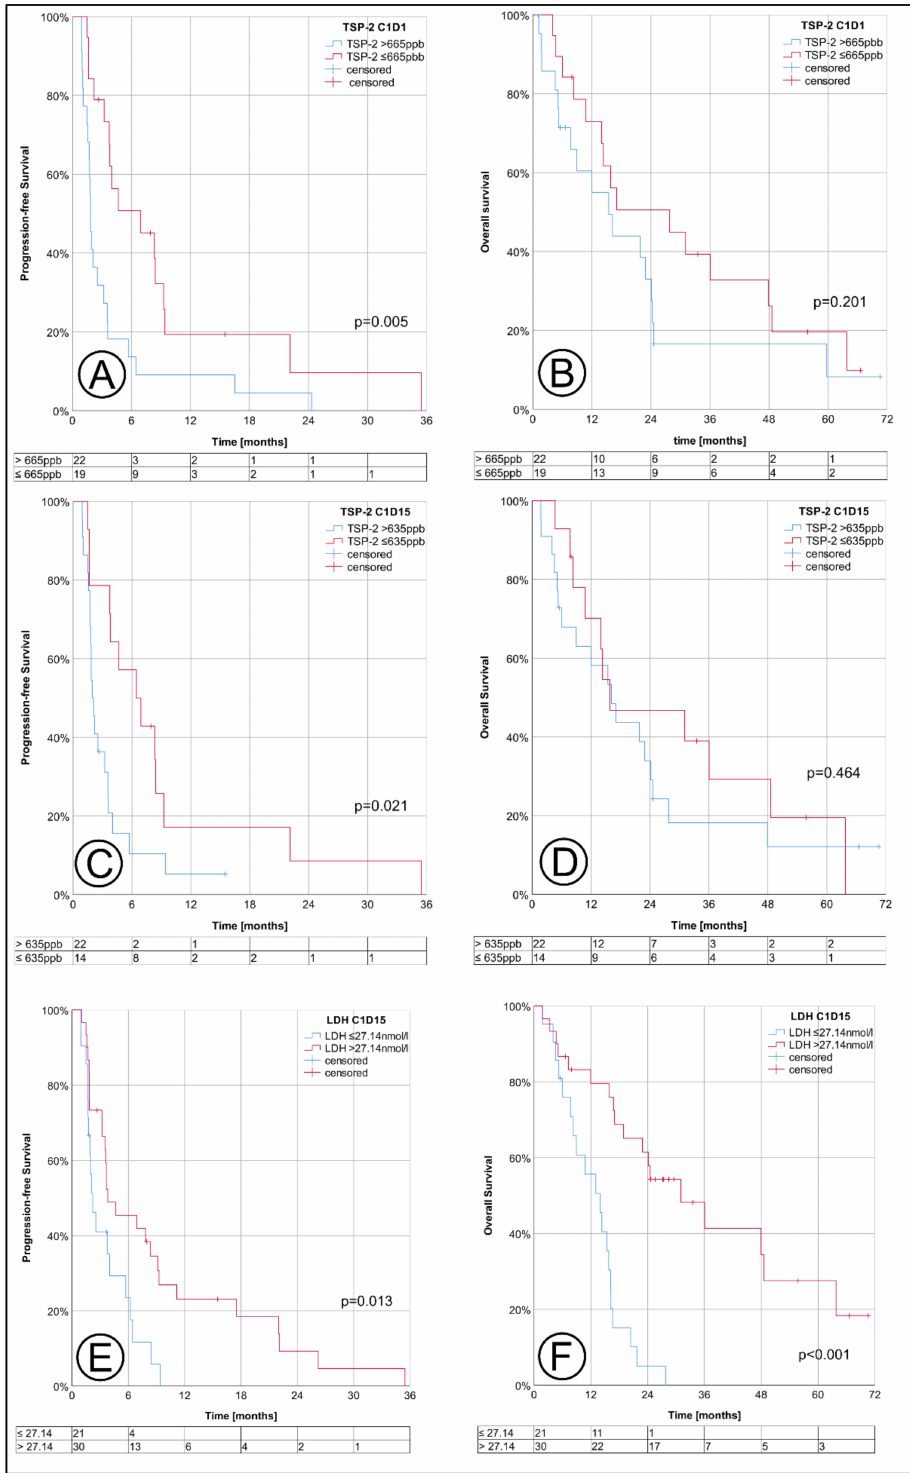
Figure 4. Progression-free survival (PFS) and overall survival (OS), stratified by thrombospondin-2 levels at baseline (see A , B ), C1D15 ( C , D ) and by the lactate dehydrogenase level at C1D15 ( E , F ). The tables below each Kaplan–Meier diagram indicate the corresponding number of patients at risk; the analysis was performed in FAS (full analysis